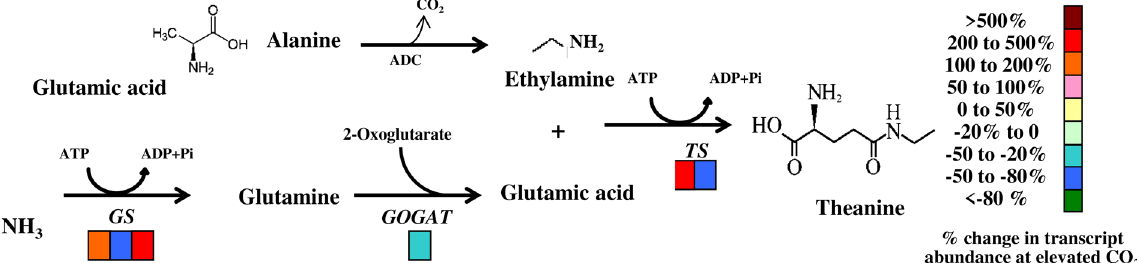
Figure 6. Expression of theanine synthetic pathway-related genes in tea leaves as influenced by ambient (380 µ mol mol − 1 ) or elevated CO 2 concentration (800 µ mol mol − 1 ). Leaf samples were harvested at 24 days following exposure of tea seedlings to different atmospheric CO 2 concentrations. Expression levels of genes were analyzed by qPCR using gene-specific primer pairs (Supplementary Table S1). Four biological replicates were used for qPCR analysis.